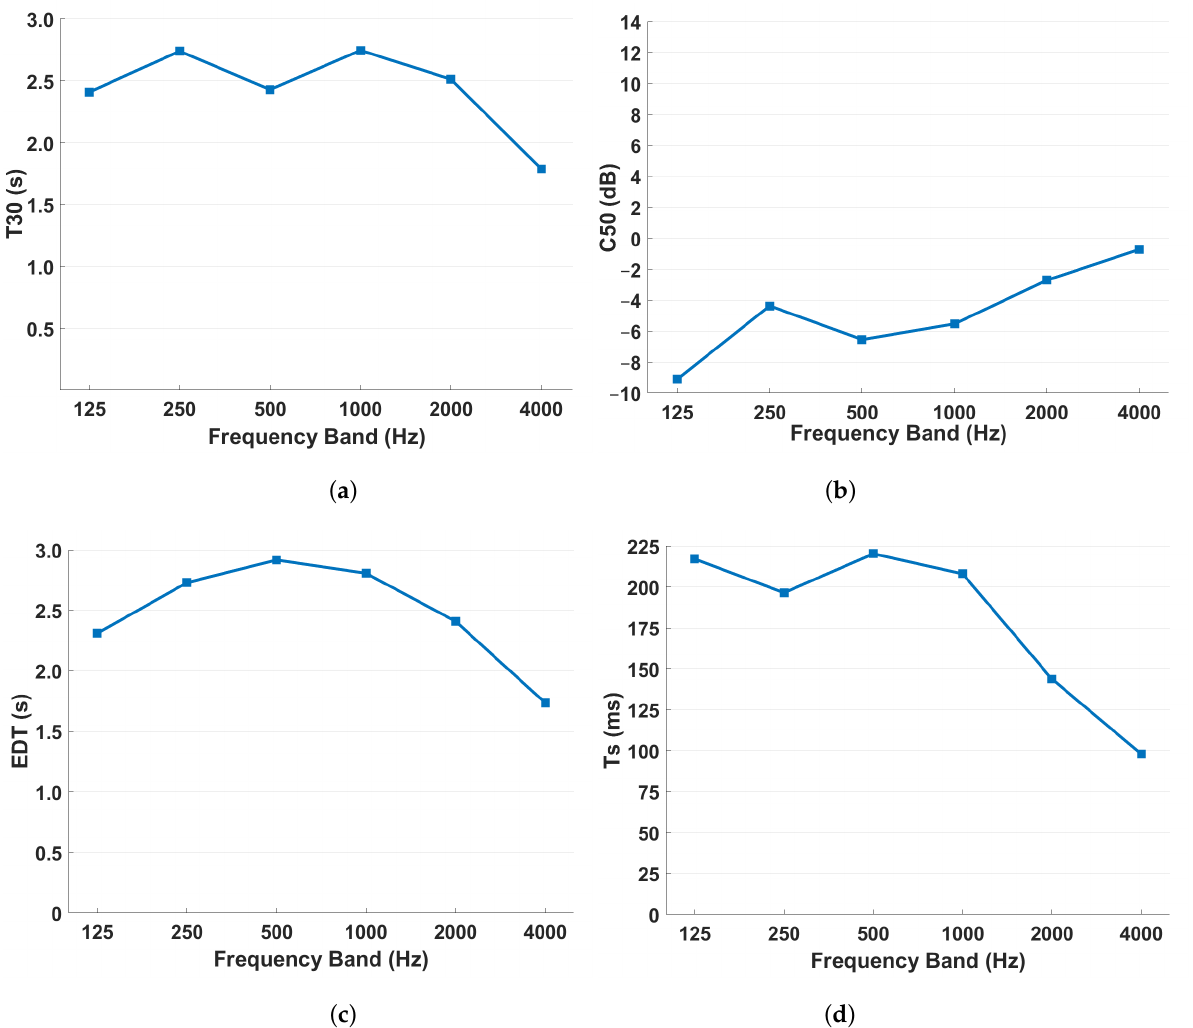
Figure 14. Results of the measured positions in Divinity School across frequency bands for ( a ) T30, ( b ) C50, ( c ) EDT and ( d )